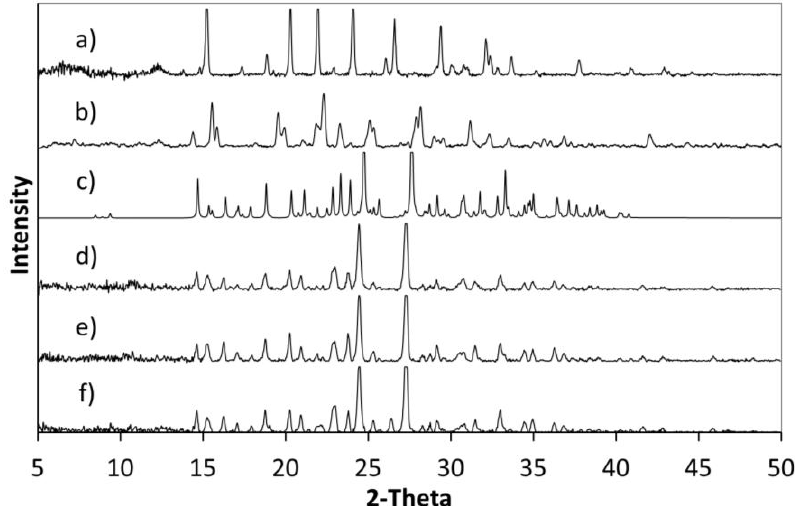
Figure 13. PXRD analysis of cooling crystallisations B, C and D. ( a ) 5FC; ( b )